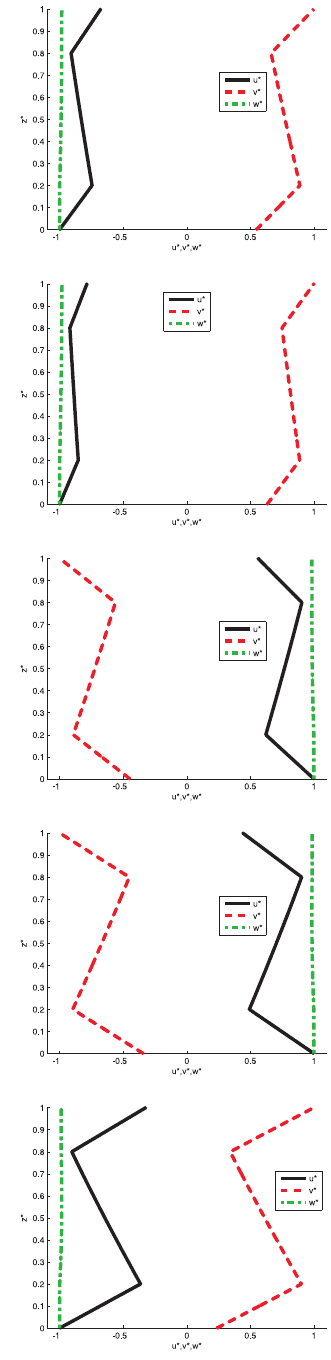
wich cylinder. FE results are acceptable for thin shells ( R α /h=1000 and 100) but they are completely wrong for thick shells ( R α /h=10 and 5). This feature is due to the big transverse anisotropy of this configuration. This trans-